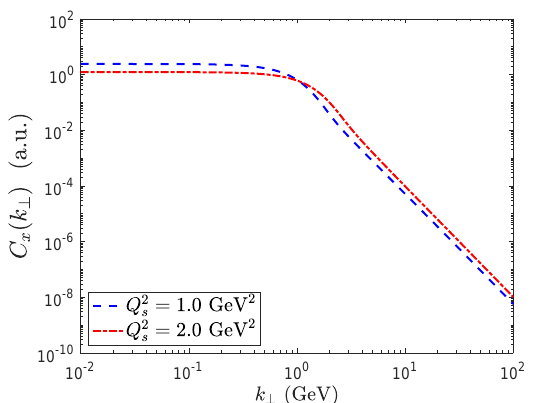
Figure 6. Fourier transform of the dipole correlator as a function of k saturation scale. A transition between saturation and perturbative regime is observed near k The x dependence of the distribution is effectively accounted by the saturation scale. In a more careful treatment, the functional shape of the distribution also depends on x